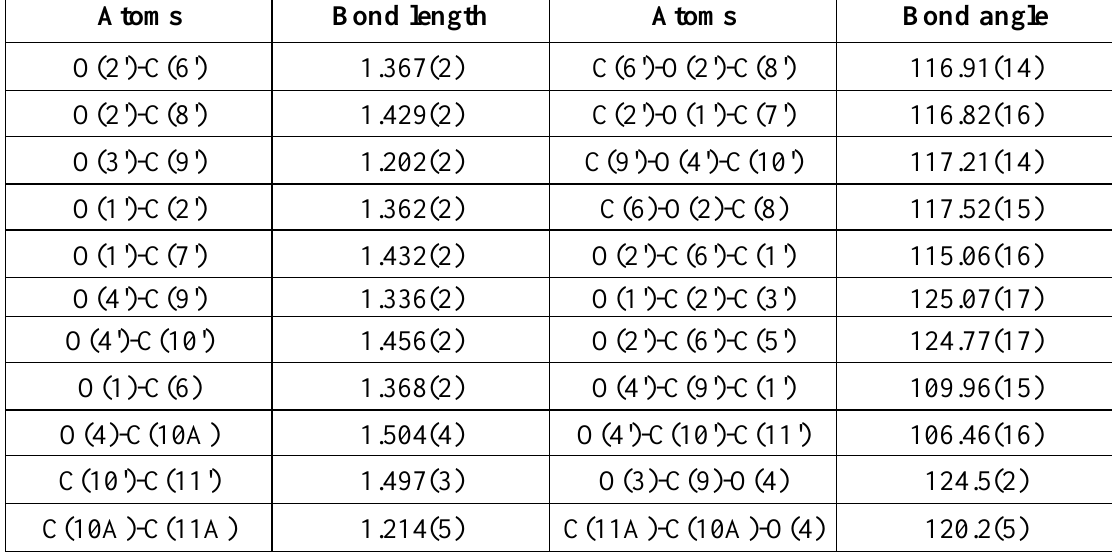
Table 1. Selected bond lengths [Å] and angles [°] in compound 2